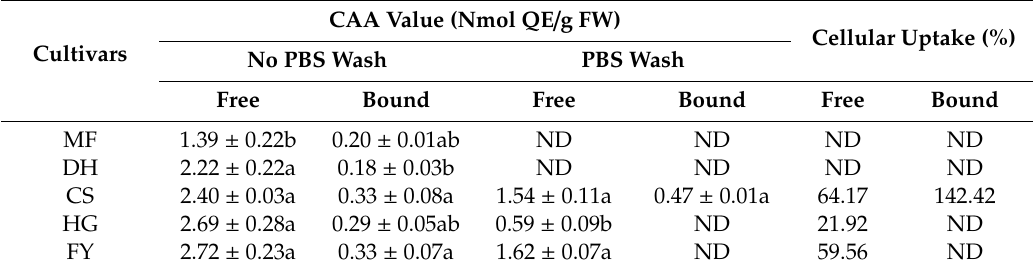
Table 2. Cellular antioxidant activities of five di ff erent chestnut cultivars.